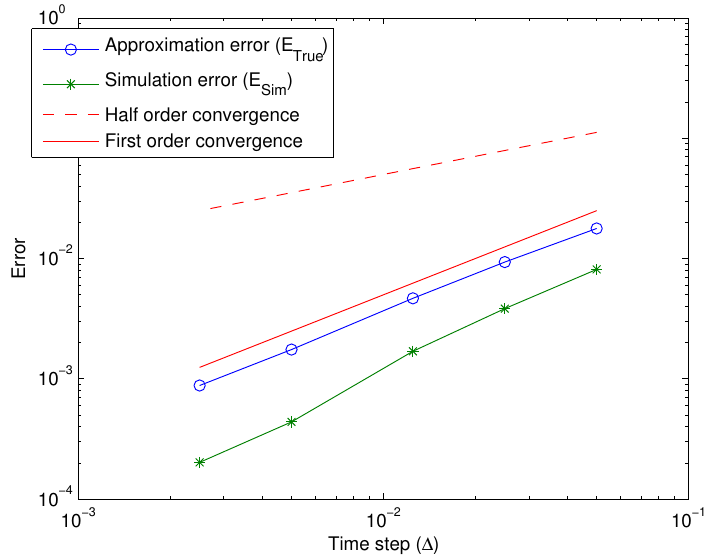
Figure 3. Log-log plot of errors using the 2-stage Runge–Kutta scheme. The sample standard deviation of the error E Sim was less than 2 × 10 − 6 for all time